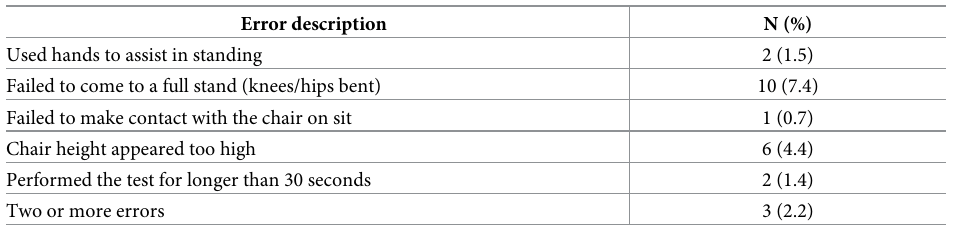
Table 2. Video-observed sit-to-stand test errors.